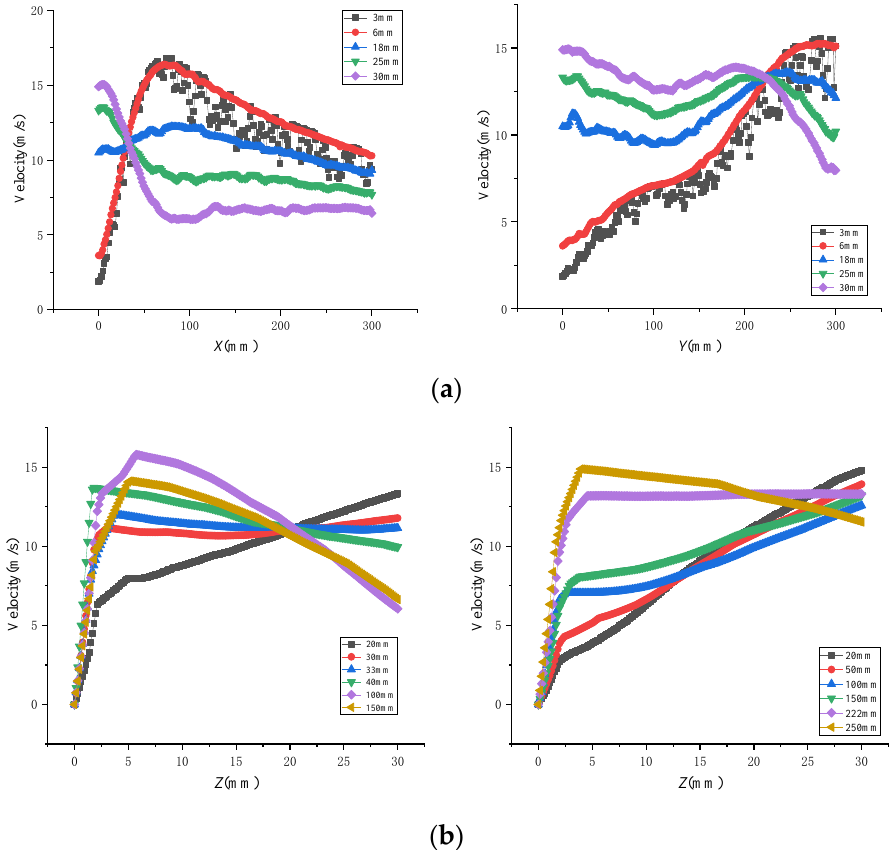
Figure 9. Velocity distributions. ( a ) Cross-sectional velocity. ( b ) Longitudinal-section velocity. There was a point where the velocities coincided in the figure. On the left side of the point, the velocity gradient was distributed along the cross-section, but the reverse veloc- ity gradient was distributed along the longitudinal section; the right side was the opposite distribution. According to the above analysis, the near-wall flow field was divided into four regions according to the velocity intersection in Figure 9. As is shown in Figure 10, the velocity gradient in zone I was upward and inward, the velocity gradient in zone II was downward and inward, the velocity gradient was upward and outward in zone III, and the velocity gradient was downward and outward in zone IV.